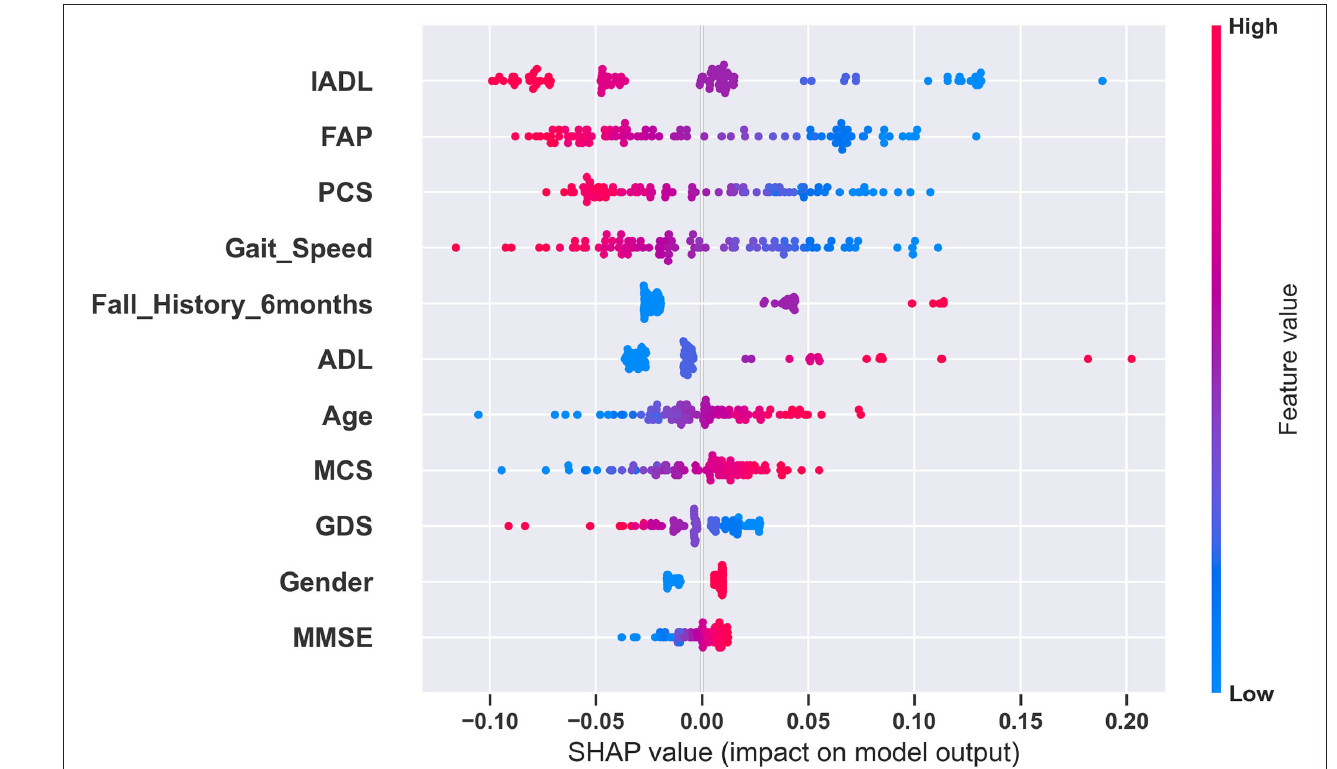
FIGURE 1 | Global explanation of the fall risk model using SHAP. This summary plot shows the relative impact of all predictors over the entire dataset. Each point represents a Shapley value for a predictor and an instance. The colors represent the higher and lower values of the predictor. The features are ordered according to the sum of SHAP value magnitudes over all samples. In this plot, based on the SHAP values for the SVM model, IADL has the highest impact and MMSE has the lowest impact in fall risk